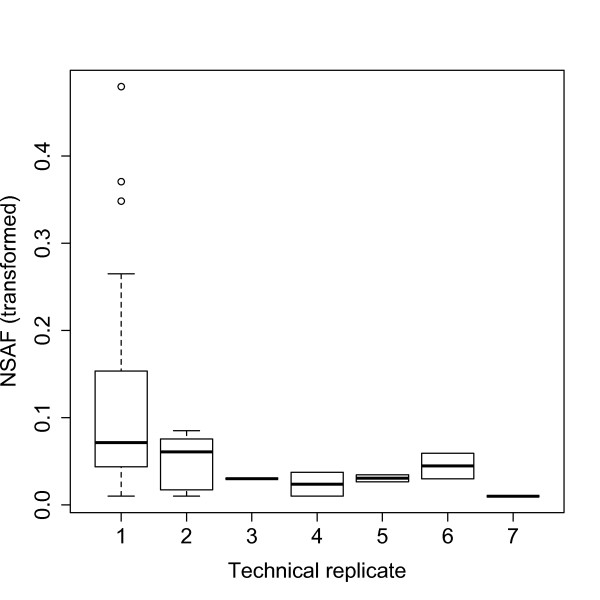
Genes discovered in the first replicate had higher NSAF (arcsin square root transformed) than genes discovered in later replicates. This pattern was seen in all four biological samples; we present one of the copulatory plug samples here. This result suggests that we have identified all reasonably abundant (and detectable) proteins under the experimental conditions employed.